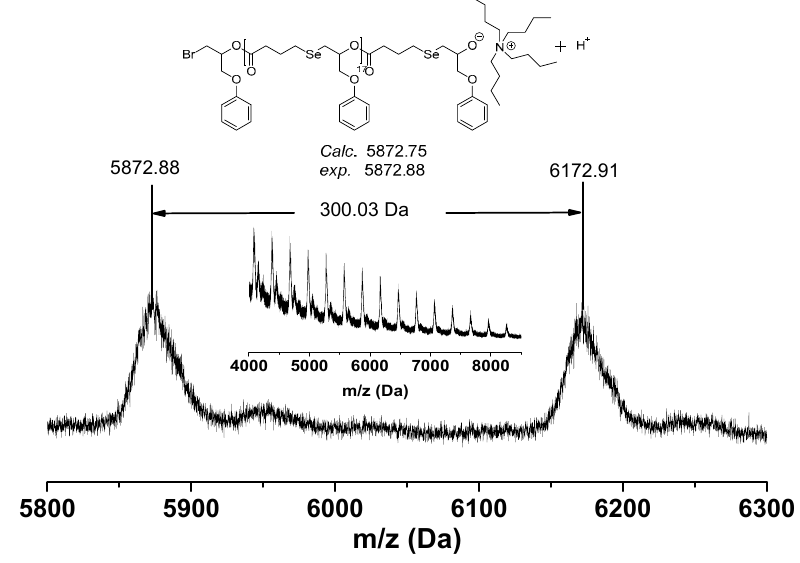
Figure 1. 1 H NMR and 77 Se NMR spectra of PSe-1 ( M n,SEC = 5800 g mol − 1 , Ð = 1.40) in CDCl 3 by using tetramethylsilane (TMS) and diphenyl selenide as the internal standard, respectively.